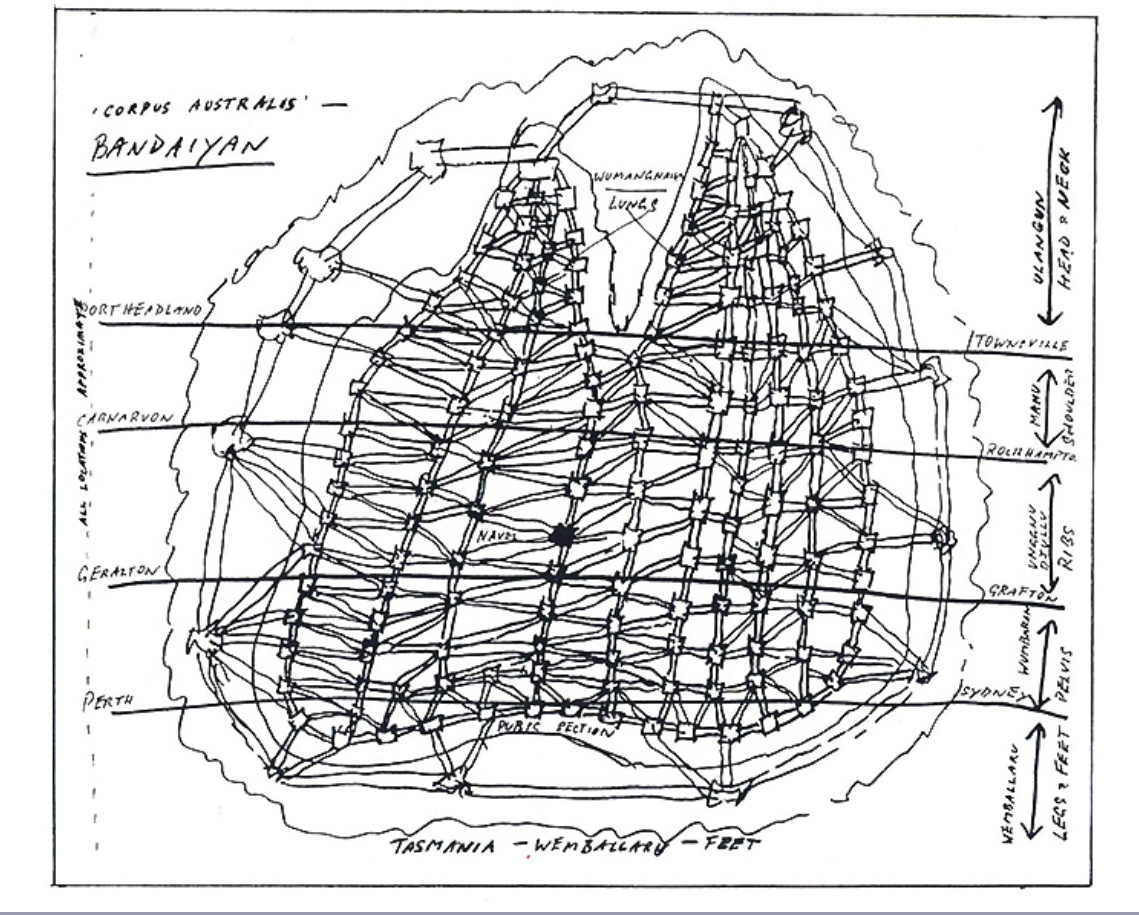
Fig. 7. Schematic representation of Dreaming song lines or “tracks” (parallel lines) and sites (points) across Australia’s lands and seas (from Mowaljarlai 1992). Ancestral characters as animals or plants formed these sites and/or tracks. The spatial connections show one means by which Aboriginal groups were linked across vast areas through ceremonies and knowledge